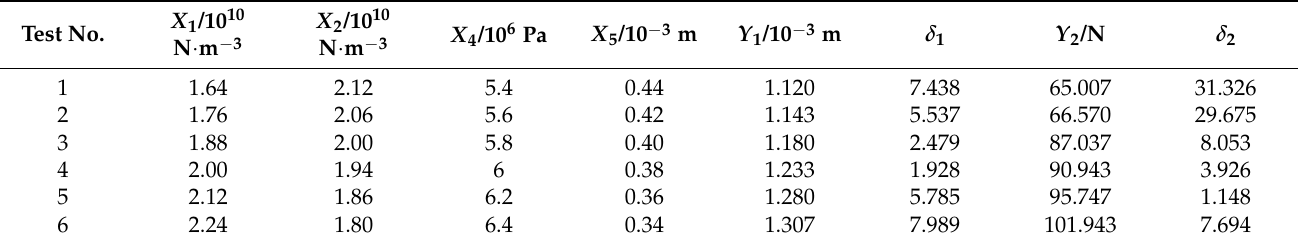
Table 9. Results of the steepest ascent